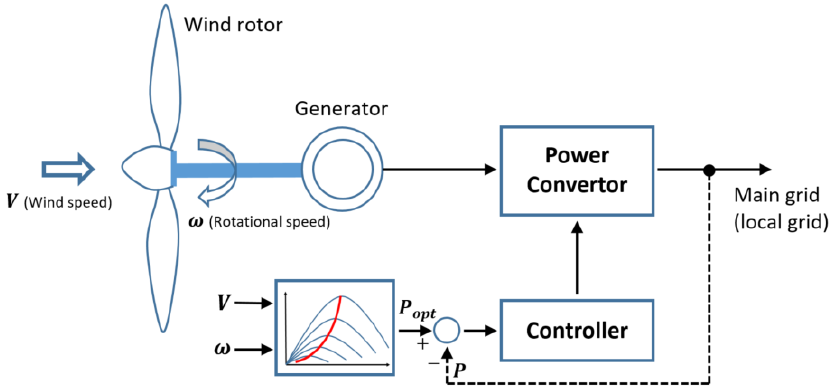
Figure 12. Control strategy of a wind turbine system.